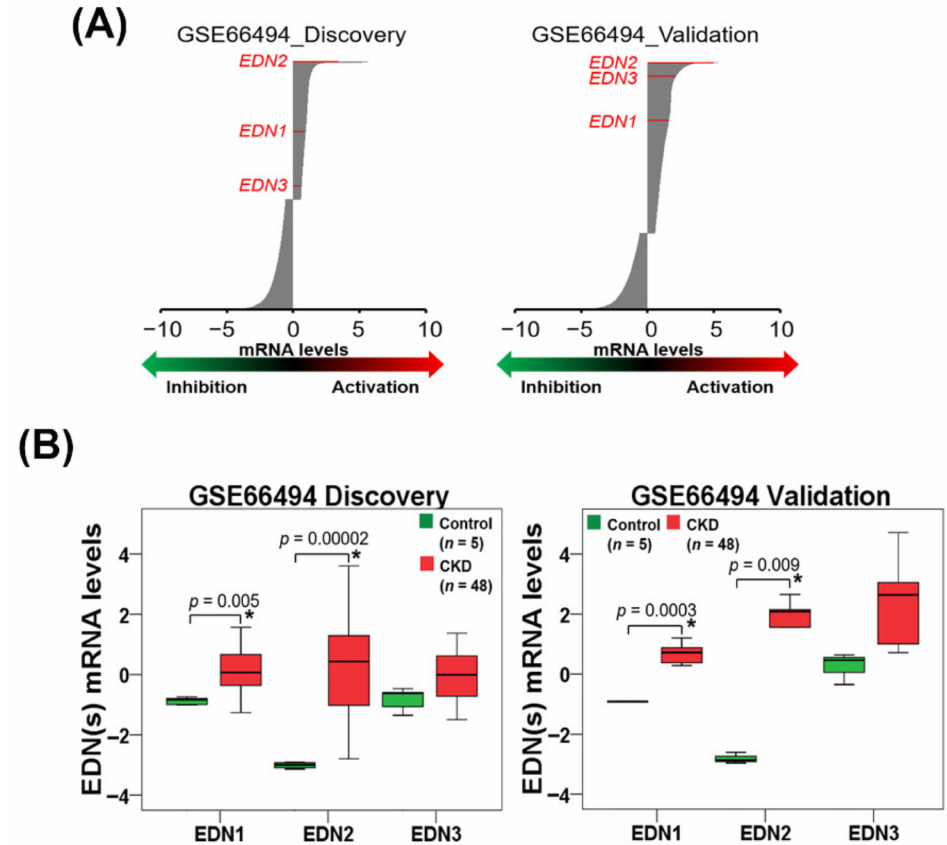
Figure 1. EDN1 , EDN2 and EDN3 expression in renal tissues of healthy individuals and chronic kidney disease (CKD) patients. ( A ) The EDN1 , EDN2 and EDN3 mRNA levels in the renal tissues of CKD patients (discovery and validation cohort in GSE66494) at a 1.5-fold change (FC) threshold. ( B ) The mRNA levels of EDN1 , EDN2 and EDN3 were upregulated in the renal tissues of CKD patients (discovery and validation cohort in GSE66494). * p < 0.05 compared with the